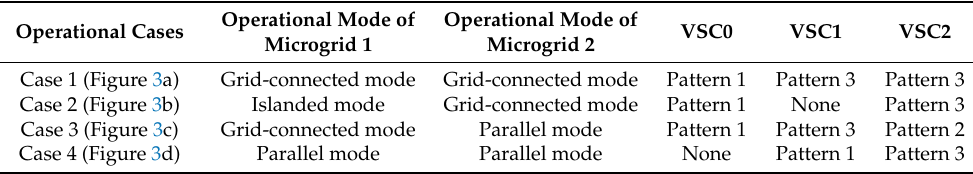
Table 2. Operational modes of the microgrids vs. VSC control patterns in Figure 3a–d.